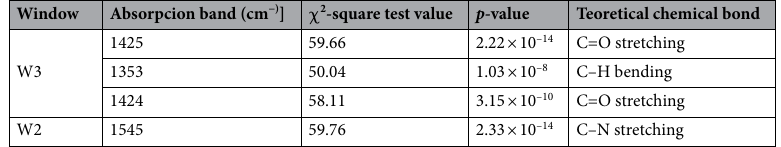
with 5 input neurons and 5 hidden neurons. This ANN is characterized by high accuracy of 96.15%—Table 5. The increasing complexity of the network (measured by the number of connections between neurons) improves the accuracy of the models. The quality of ANNs was assessed by 13 indicators based on the number of correctly and incorrectly classified cases. The best ANN is characterized by a high true positive rate (TNR) and true negative rate (TNR) of 98% and 92%, respectively. The value of the diagnostic odds ratio (DOR) is 598, so the neural network discriminates correctly the serum samples.